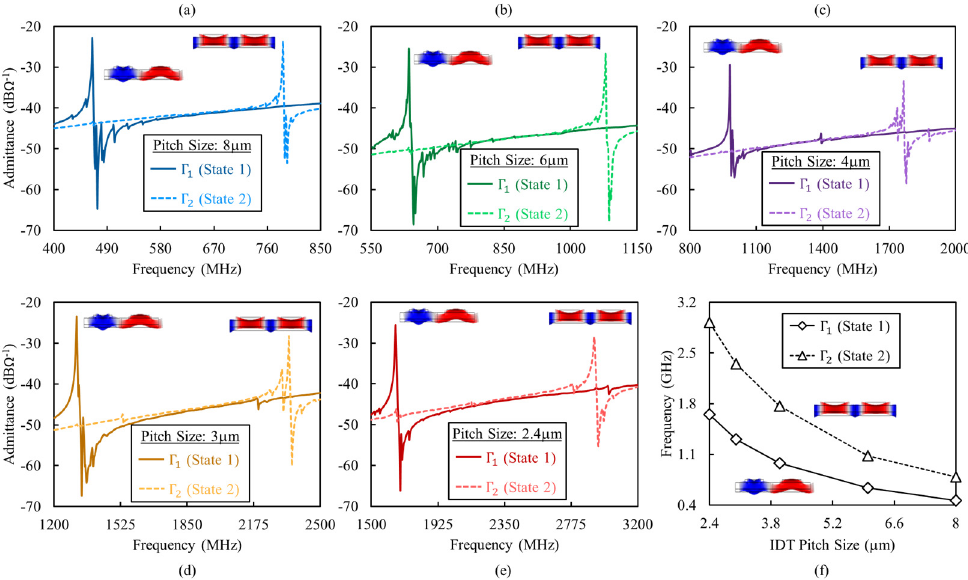
Figure 6. Measured admittance of dual − mode Sc 0.28 Al 0.72 N Lamb − wave resonators when oper- ating in either of the complementary switchable states defined by periodic poling procedure. The admittances are shown for resonators with ( a ) 8 mm, ( b ) 6 mm, ( c ) 4 mm, ( d ) 3 mm, and ( e ) 2.4 mm IDT pitch sizes. ( f ) The frequency of Γ 1 and Γ 2 modes for different IDT pitch sizes, highlighting the coverage of the 0.45 − 3 GHz